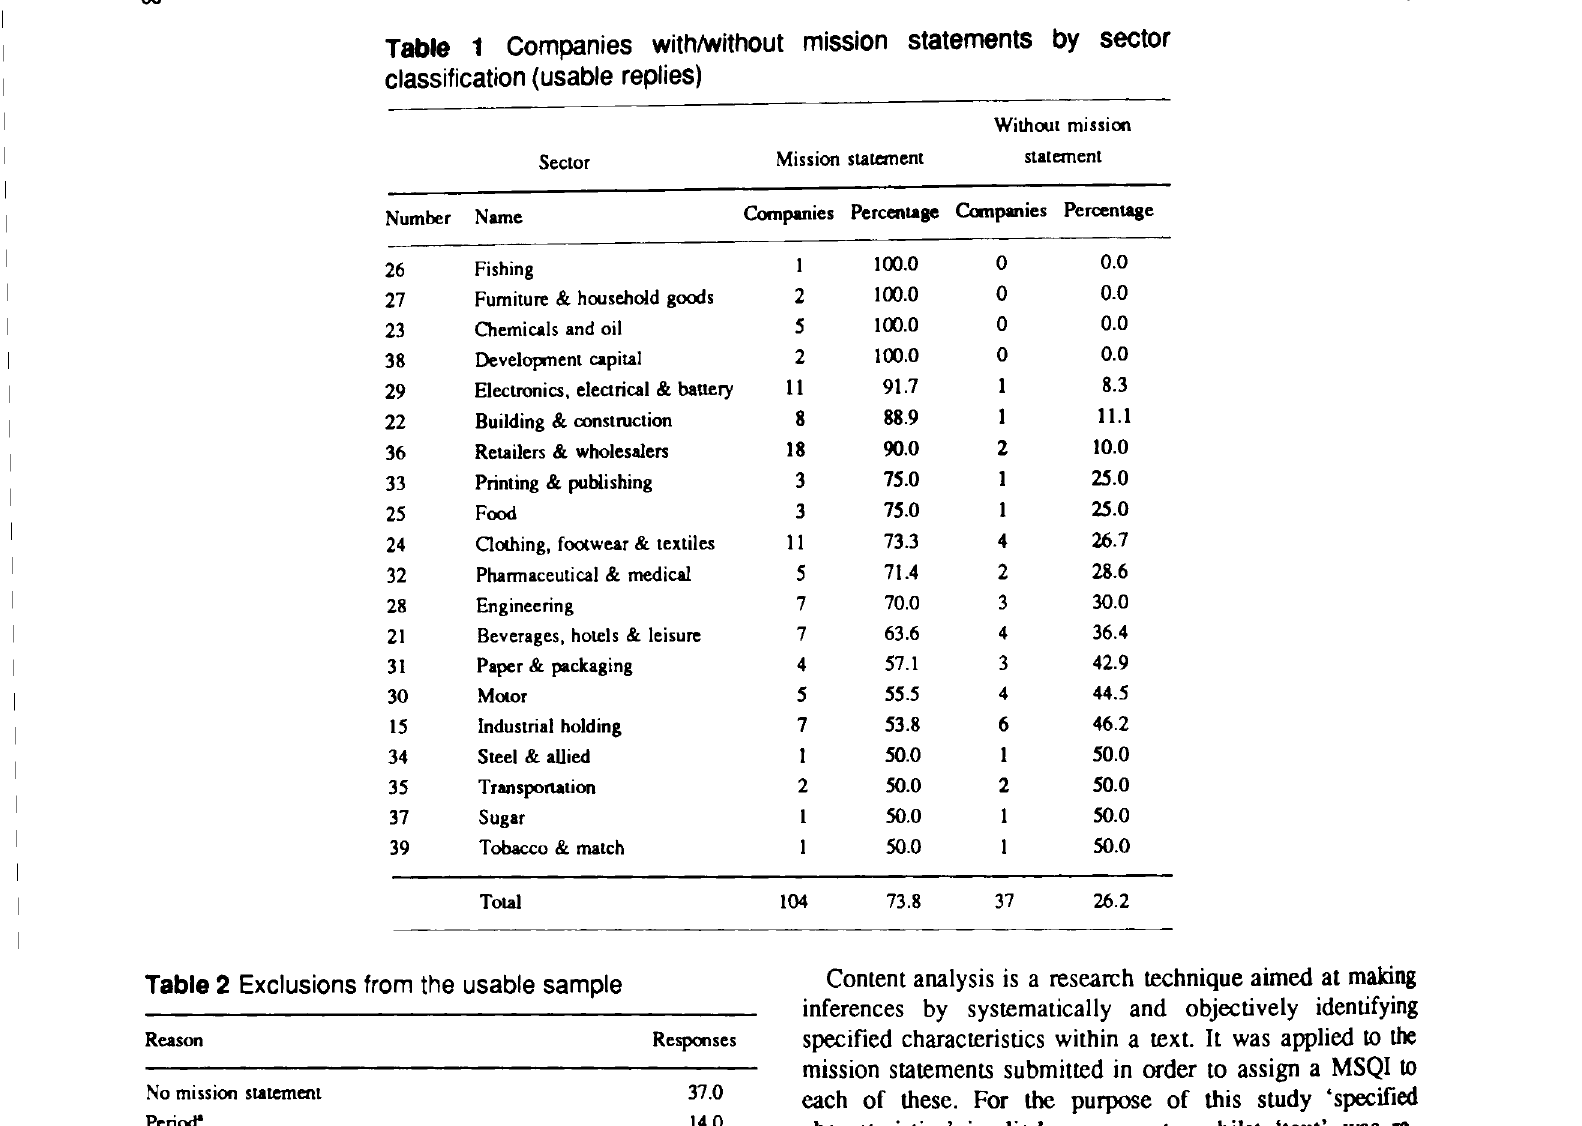
Table 1 companies with/Without mission statements by sector